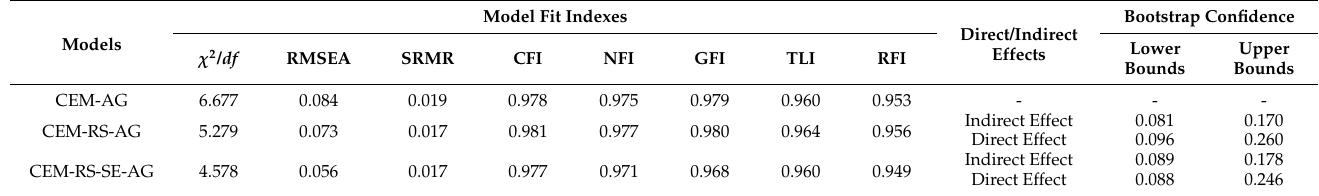
Table 3. Mediation effects of childhood emotional maltreatment on aggression via resilience and self-esteem ( n =